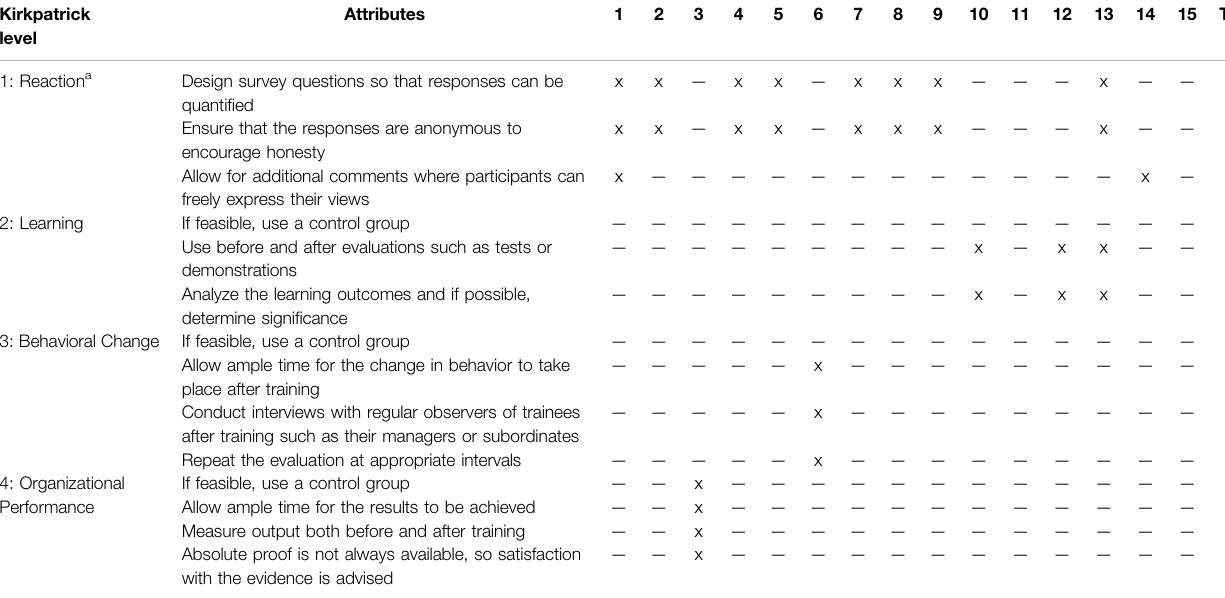
TABLE 2 | Connections to the Kirkpatrick guideline from 15 construction industry training studies. Kirkpatrick